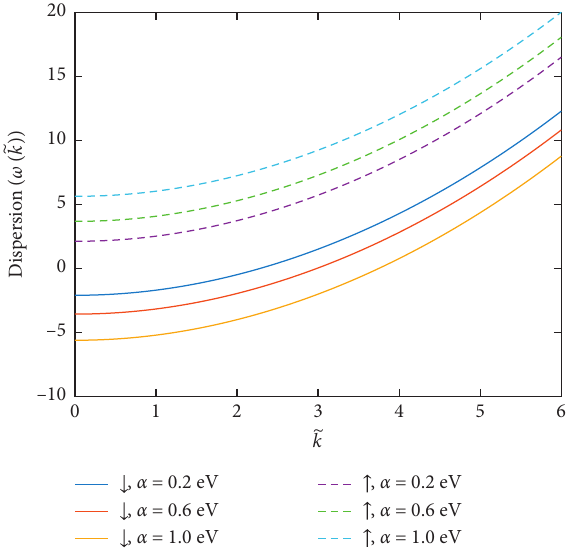
Figure 2: Carrier spin polarization as a function of temperature for different values of EEF parameter α .